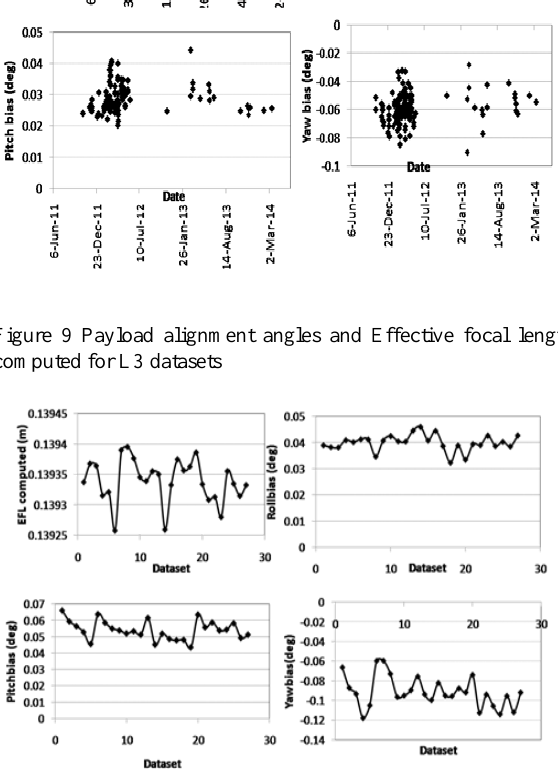
Figure 10 Payload alignment angles and Effective focal length computed for AWF-A datasets